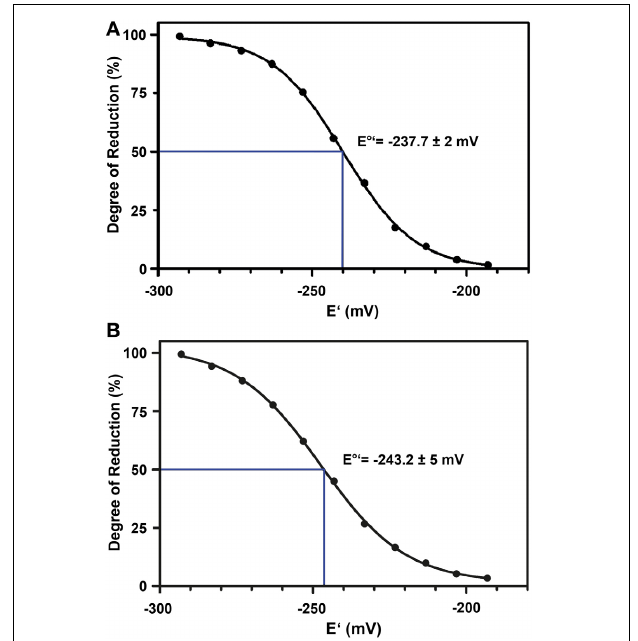
FIGURE 4 | Redox titration of roGFP2-iL and GRX1-roGFP2-iL. The degree of reduction of roGFP2-iL (A) and GRX1-roGFP2-iL (B) was determined from the excitation ratios plotted against the potential of the ambient redox buffer. Representative measurements of at least 3 independent redox titrations (with 4 replicates each) for both probes are